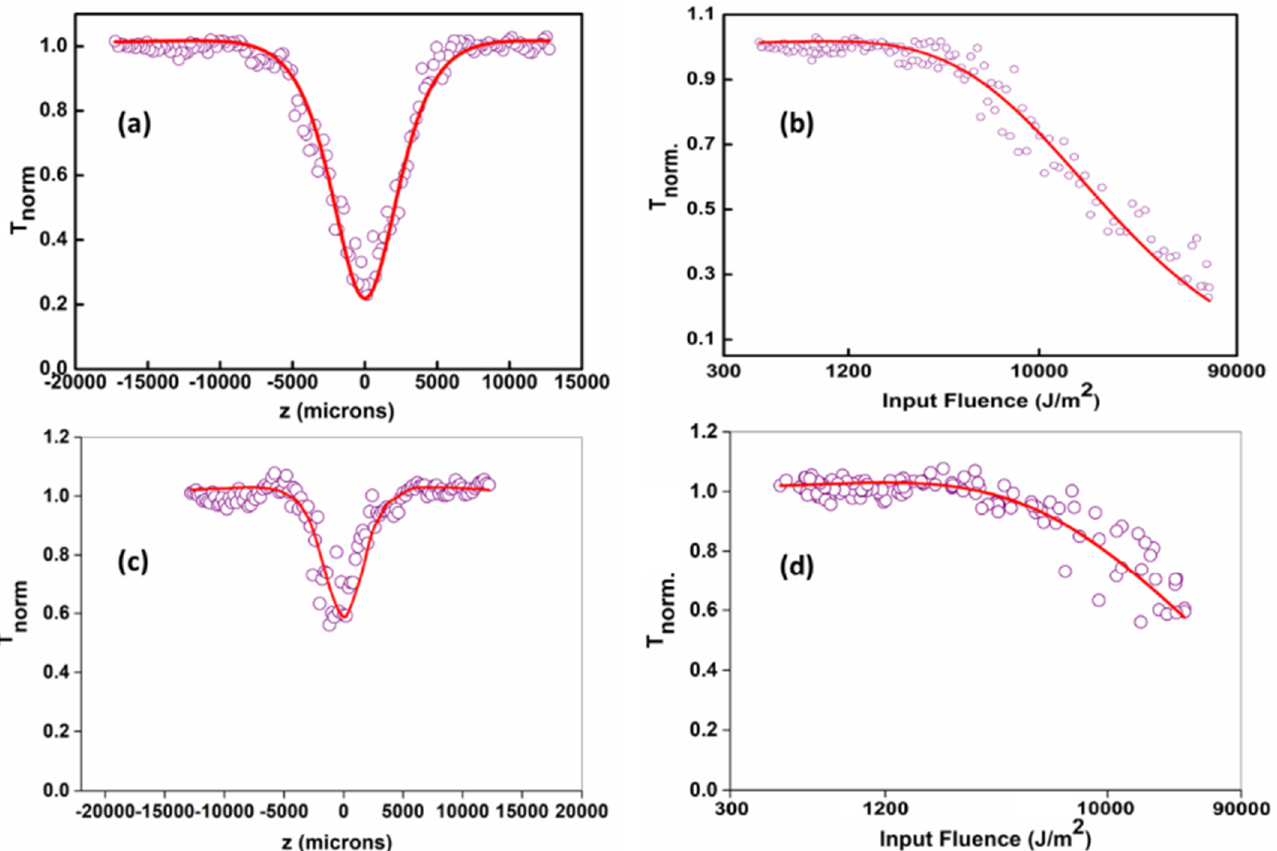
Figure 6. ( a , b ) Open aperture z-scan of GQDs@532 nm, 5 ns laser pulse excitation at laser pulse energy of 25 µJ. ( c , d ) Open aperture z-scan of GQDs@355 nm, 5 ns laser pulse excitation at laser pulse energy of 25 µJ. Open circles: data points, solid lines: numerical fits to the data points.